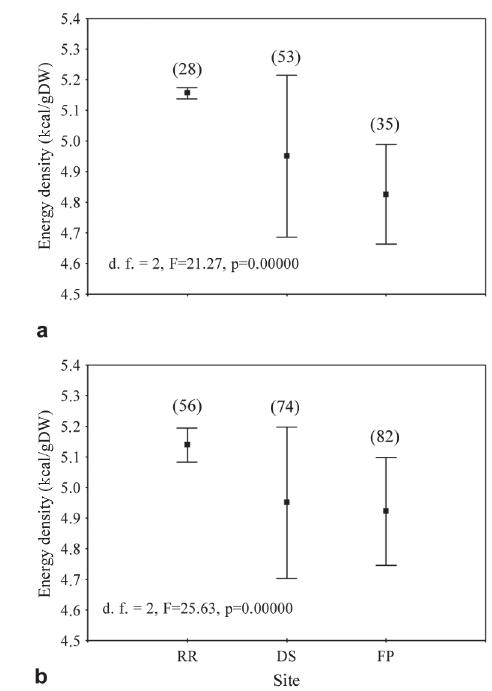
Fig. 3. Mean ± standard deviation for muscle energy density of Loricariichthys platymetopon of both the sexes and same gonadal development stages (spent and resting) ( a ) and for both sexes and all stages sampled in the Rosana Reservoir (RR), Diamante Stream (DS) and upper Paraná River floodplain (FP) ( b ). Number of specimens between parentheses. One- way ANOVA results are presented.